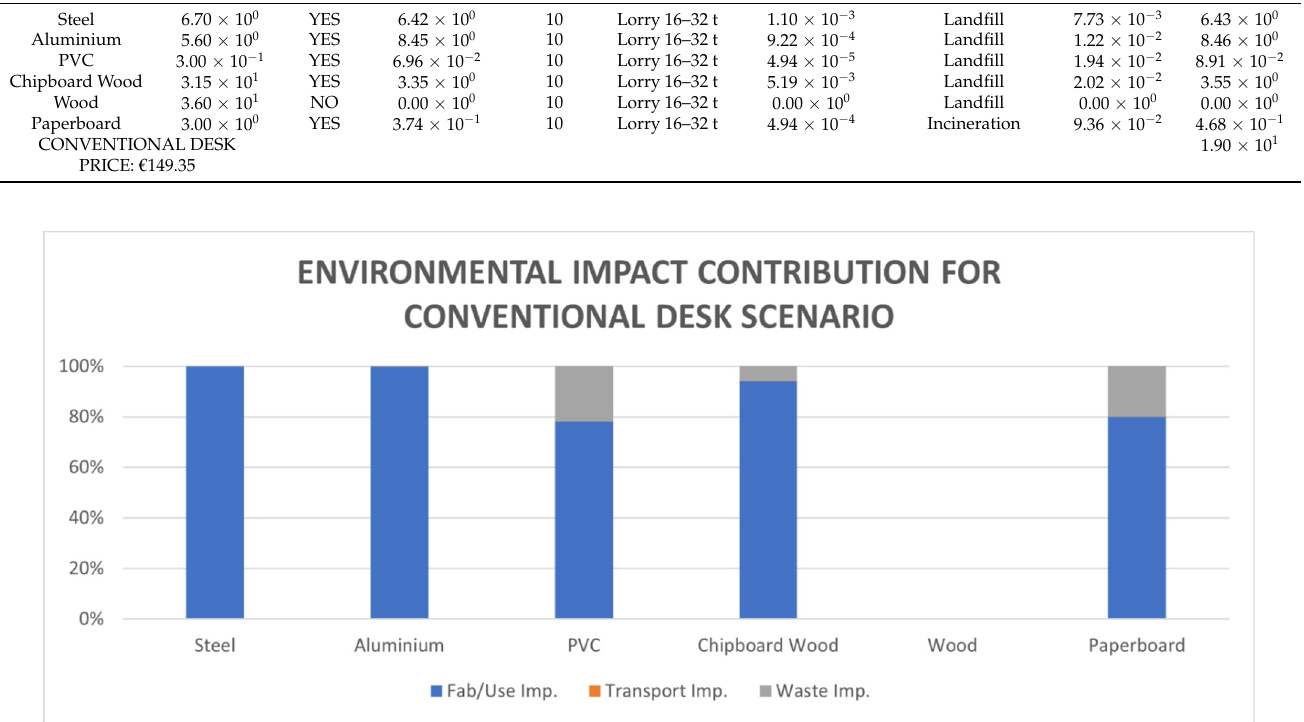
Figure 1. Environmental impact contribution for conventional desk scenario. According to the results obtained for the base case, the environmental impact of the initial design would be 1.90 × 10 1